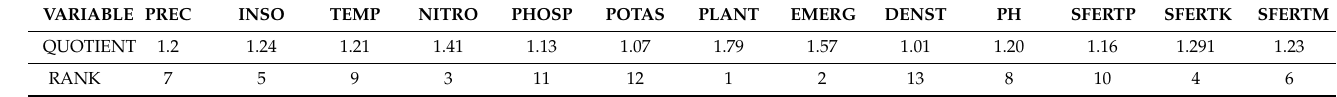
VARIABLE QUOTIENT